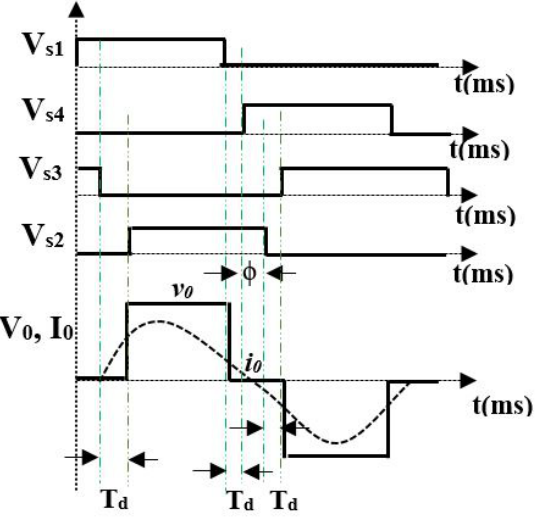
Figure 3. Typical waveforms of phase shift